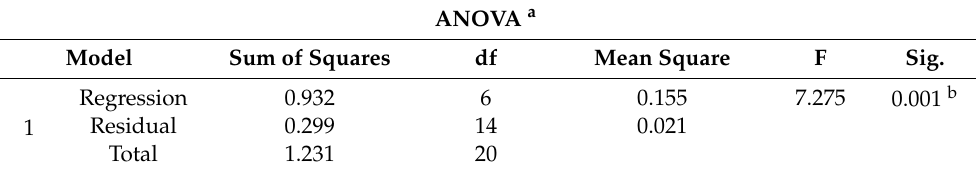
Table 6. ANOVA method for